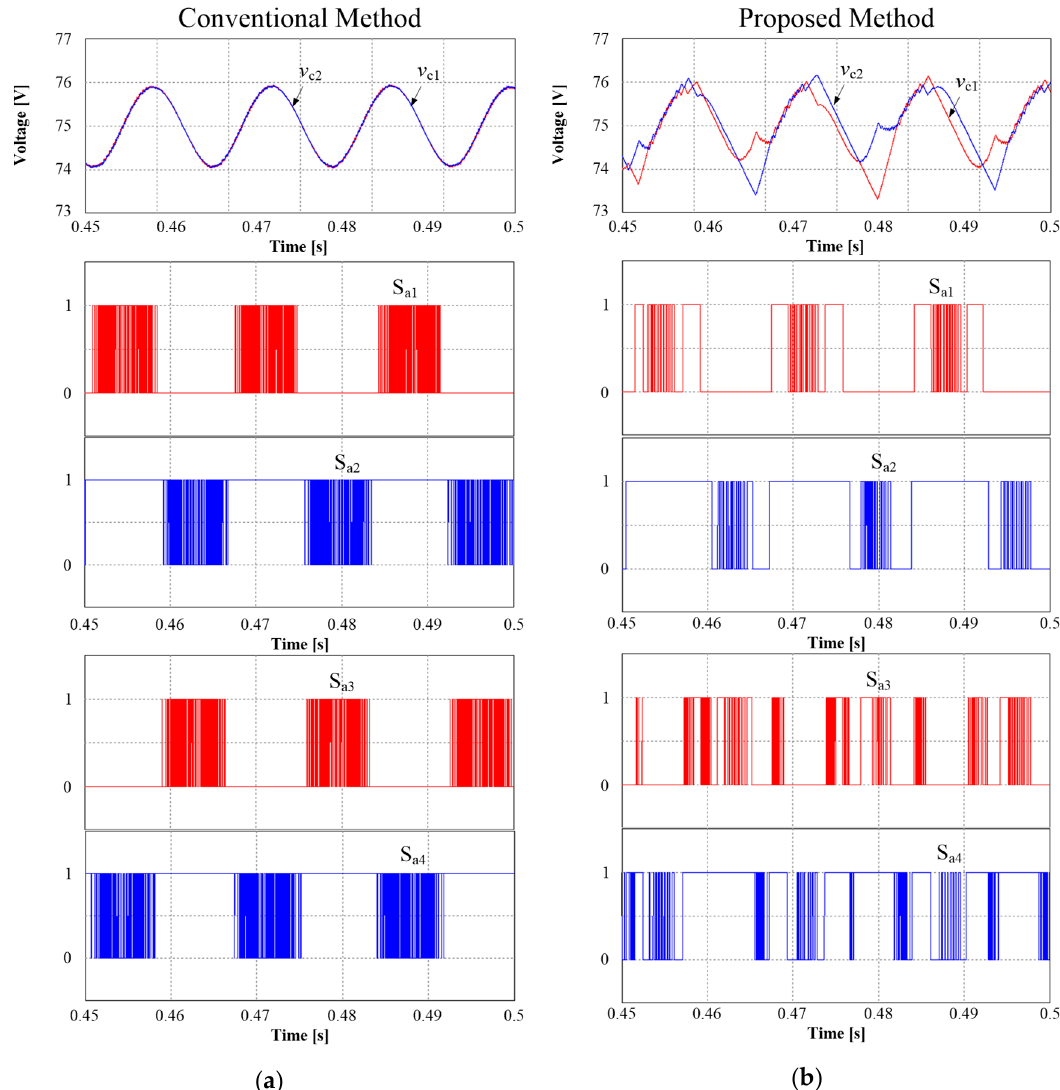
Figure 9. Simulation results of upper and lower capacitor voltages ( v c1 , v c2 ) and switching patterns of four upper switches ( S a 1 , S a 2 , S b 1 , S b 2 ) during steady state in ( a ) conventional MPC method and ( b ) proposed MPC method.